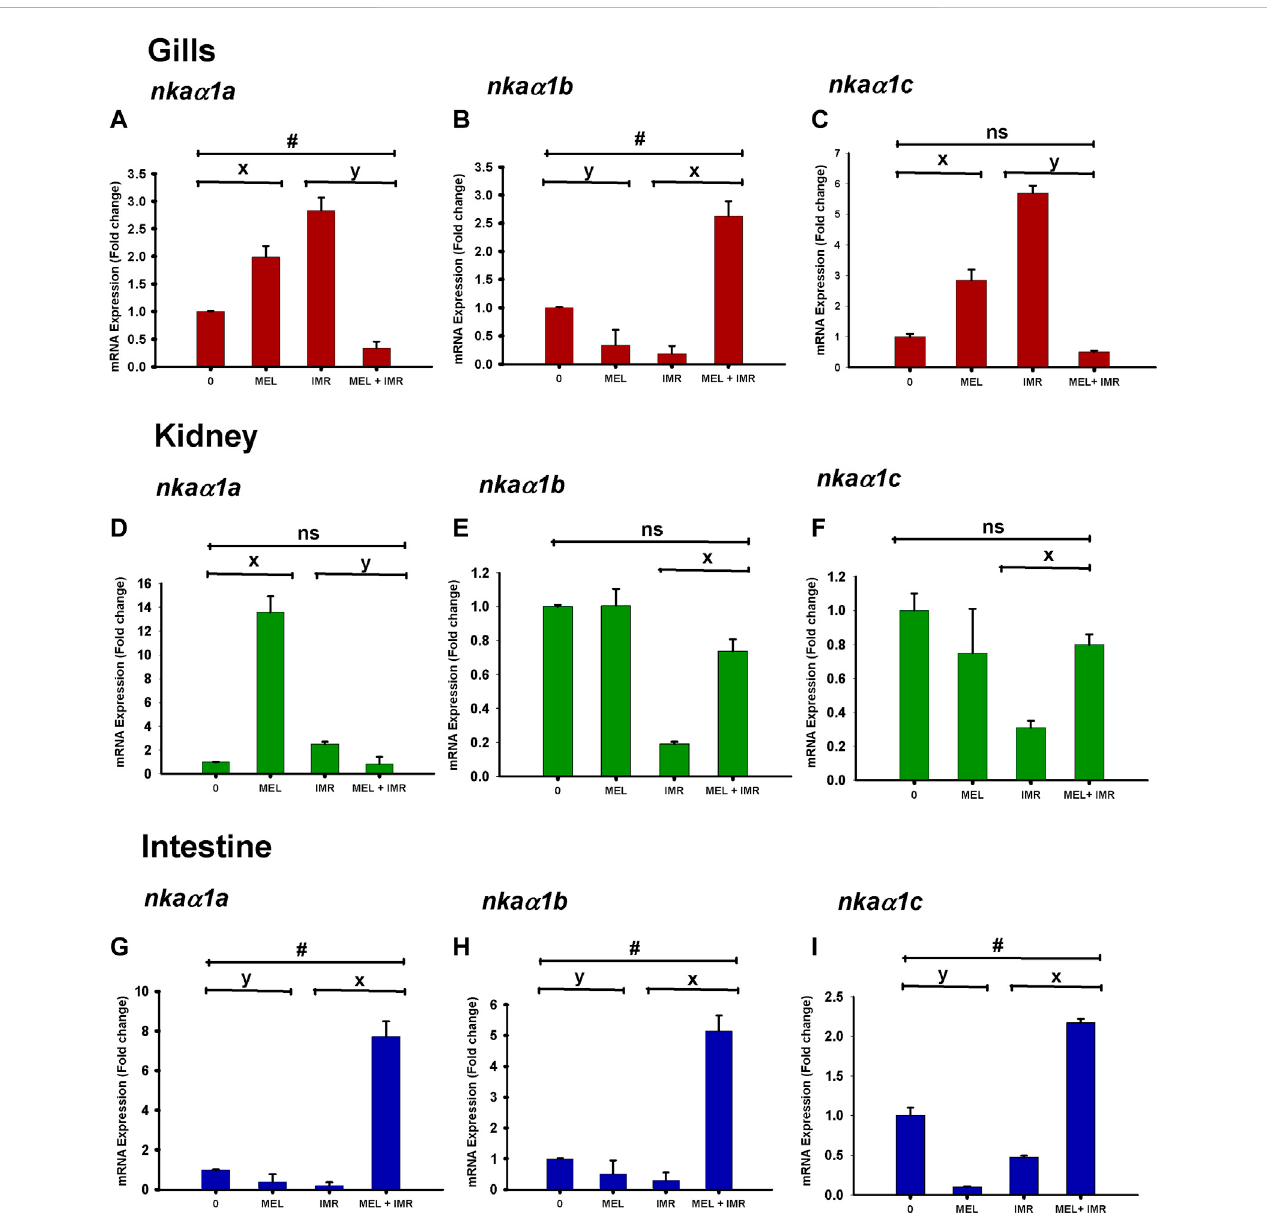
FIGURE 3 Relative mRNAexpression ofNKA α 1-subunitisoform nka α 1a (A,D,G) , nka α 1b (B,E,H) and nka α 1c (C,F,I) innon-stressed andimmersionstressed fi sh after melatonin-treatment (MEL; 50 ng g − 1 ). 18S rRNA was used as the endogenous control. The data obtained from each group were statistically analyzed using Relative Expression Software Tool 2009 (REST) and the signi fi cant levels are represented. “ * ” represents signi fi cance between non-stressed control (0) and melatonin(MEL)treatedorcomparisonbetweenIMRandMEL+IMR fi sh. “ # ” denotessigni fi cancebetweennon-stressed control(0)andMEL+IMR fi sh.